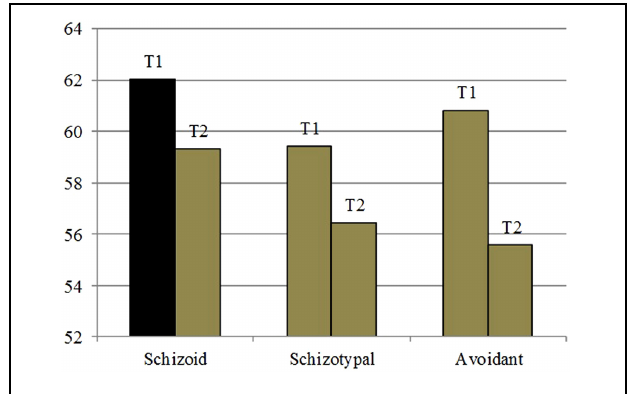
FIGURE 3 | SWAP-200 PD-T Scores at the beginning of the psychotherapy and after 1 year.